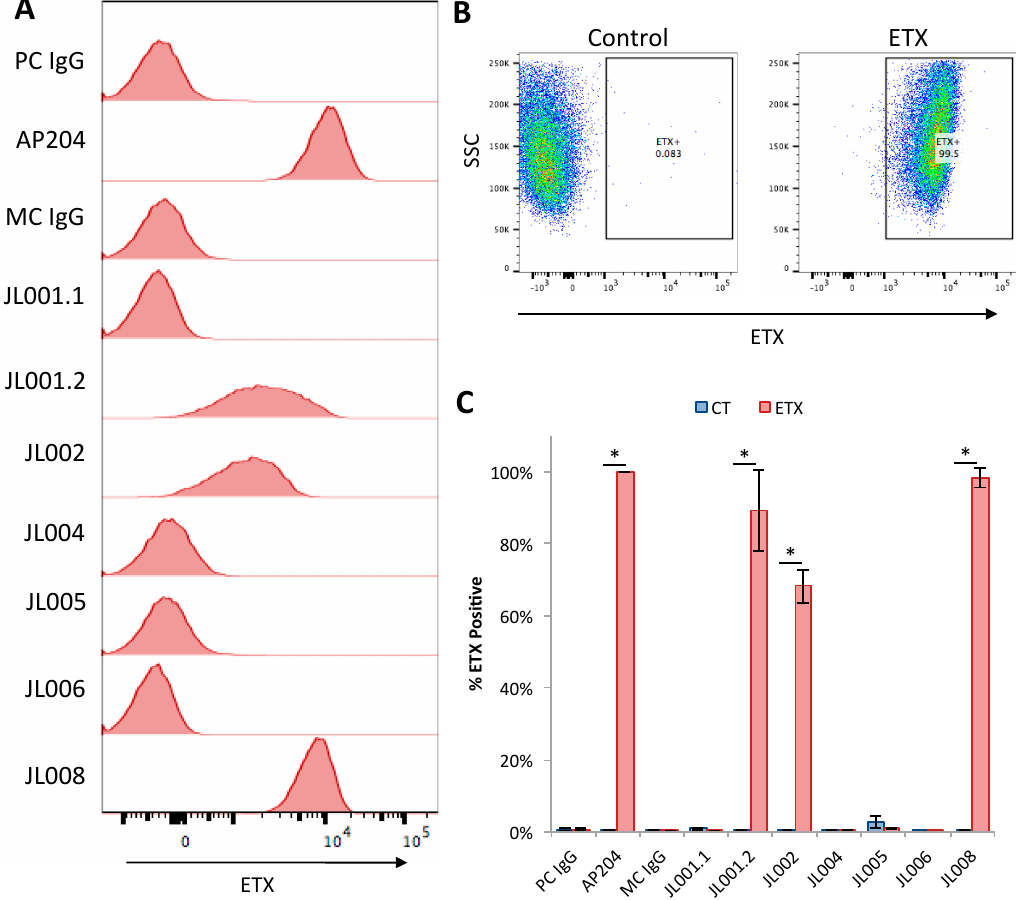
Figure 6. Evaluation of ETX detection via flow cytometry. rMAL-CHO cells were treated with ETX, trypsinized, fixed, blocked, and then probed with anti-ETX antibodies. Bound antibody was detected using a PE conjugated anti-rabbit antibody. ( A ) Histograms of ETX fluorescence for different antibodies. A non-specific polyclonal IgG isotype control (PC IgG) was used a negative control for affinity-purified polyclonal (AP204). A monoclonal IgG isotype control (MC IgG) was used as a negative control for monoclonal antibodies JL001.1, JL001.2, JL002, JL004, JL005, JL006, and JL008. Representative examples of experimental triplicates. ( B ) Representative dot blots of control and ETX-treated rMAL-CHO cells probed with JL008. ( C ) Percent of cells positive for ETX when probed with indicated antibodies. Control treated cells were compared to ETX-treated cells. Results are mean ± SD. * p < 0.002 determined by t -test.